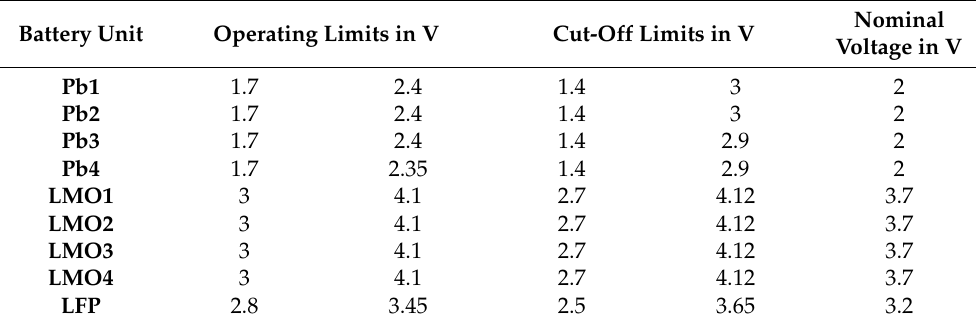
Table 3. Voltage limits and nominal voltage of the battery units according to the manufacturer’s specifications [23].